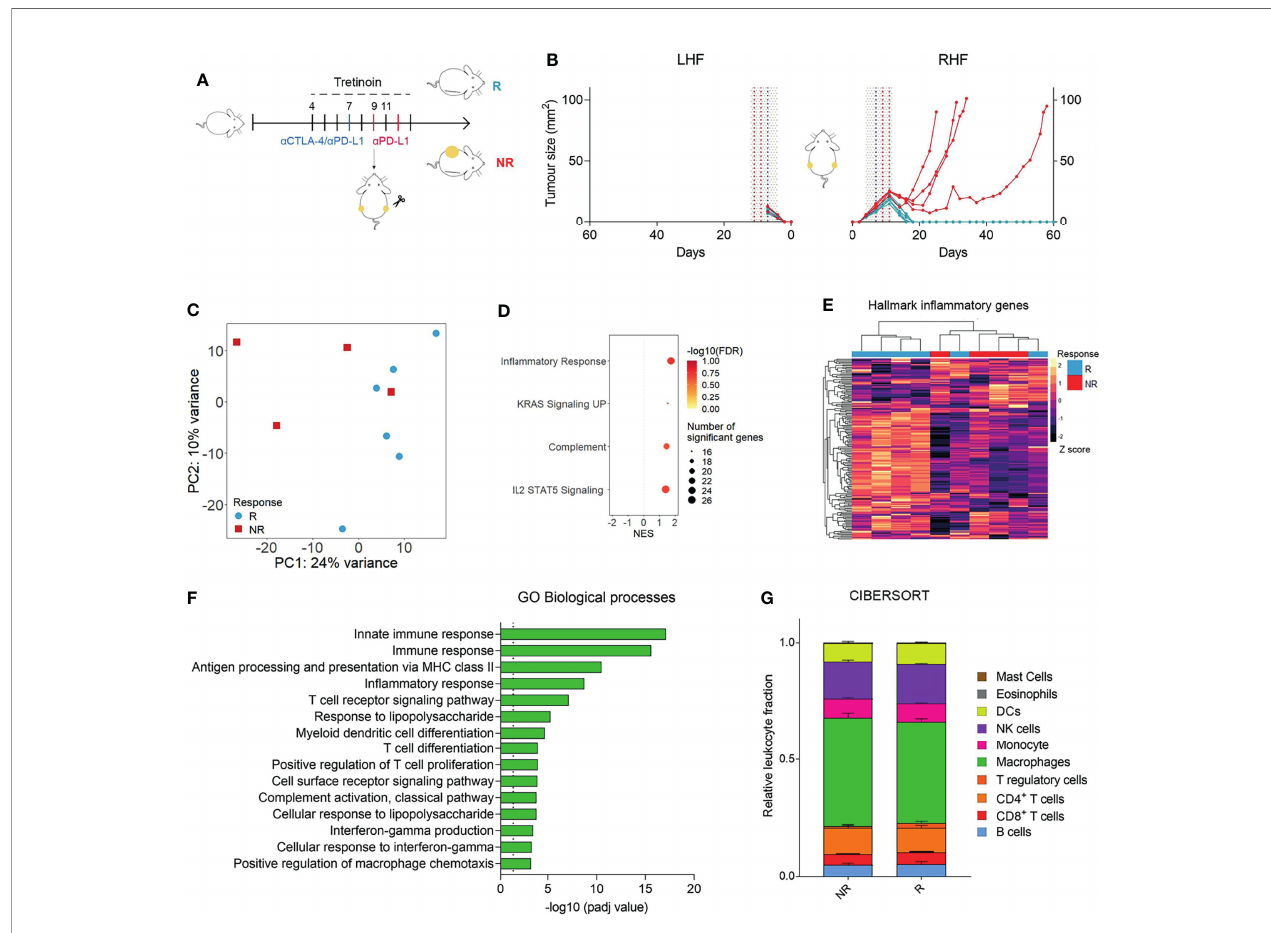
FIGURE 4 | Responding tumours to ICT/ATRA treatment are enriched for in fl ammatory, IFNy related genes. (A) Experimental design. Mice were inoculated bilaterally with AB1-HA and treated with tretinoin (5mg/kg) followed by a CTLA-4 and a PD-L1 as indicated (tumour size start of treatment ~4 mm 2 ). One tumour was surgically resected on day 9 and analysed using RNAseq. The remaining tumour was monitored for treatment outcome; responders (R, blue n=6) or non-responders (NR, red, n=4). (B) Tumour growth curves of the unresected right hind fl ank (RHF) or resected left hind fl ank (LHF). (C) PCA plot of R and NR to tretinoin/ICT. Counts were VST normalized and batch corrected. (D) GO biological processes upregulated in responders. (E) GSEA analysis of hallmark gene sets upregulated (positive NES) or down regulated (negative NES) in R compared to NR. (F) Heatmap displaying the expression of hallmark in fl ammatory genes, VST normalized and Z scored. (G) Relative fractions of cell populations as determined by